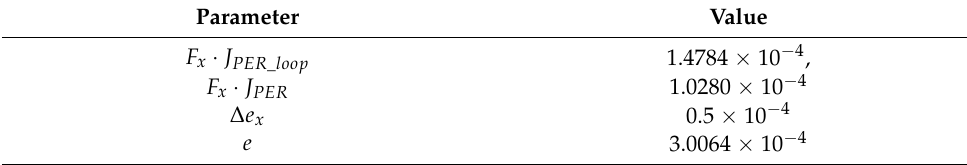
Table 4. Relative errors of frequency caused by surface crystal and Schmitt